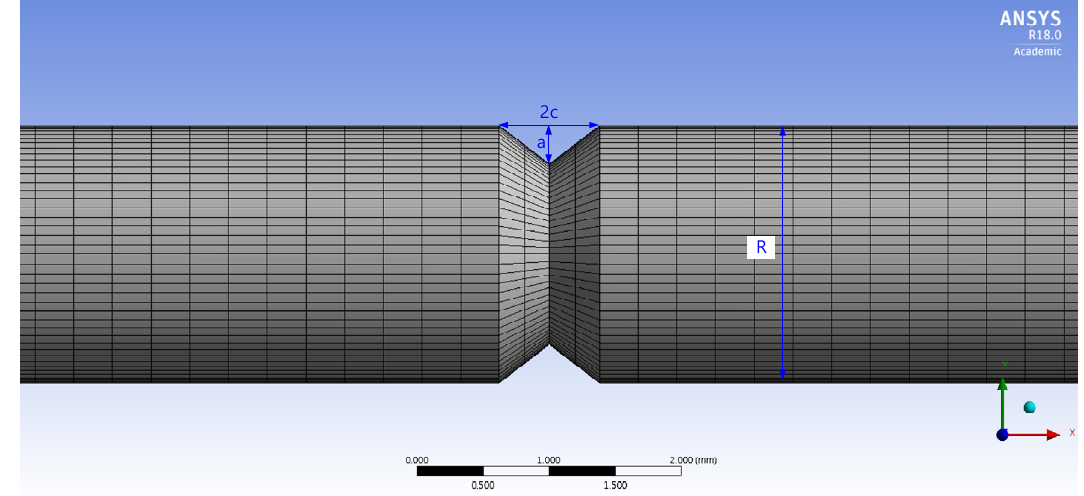
Figure 4. Meshed 3D model applied to computer simulation.